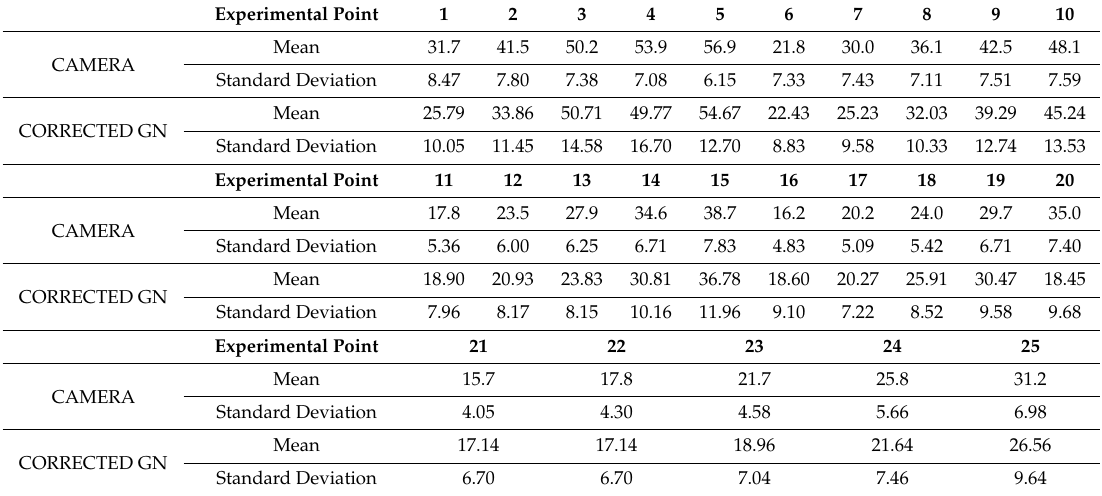
Table A2. Statistical Data of Figure 19. Values in